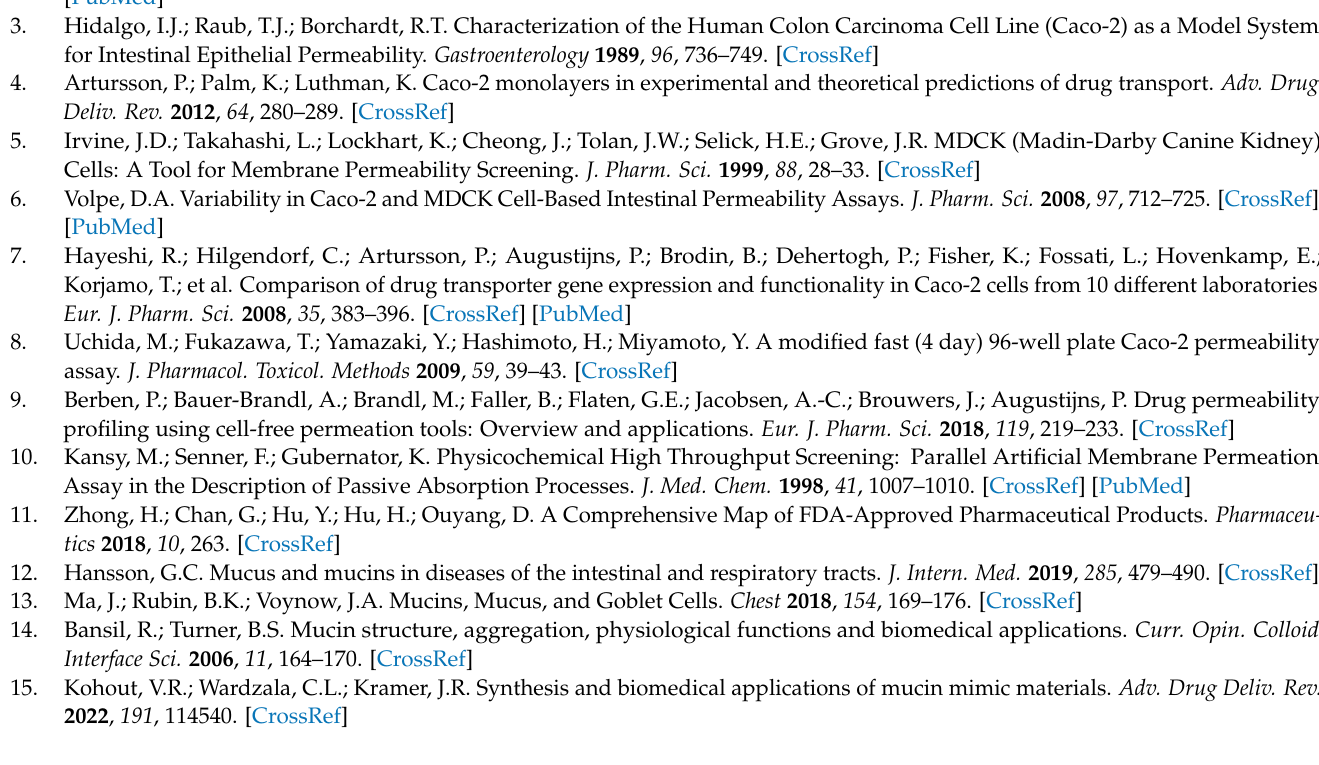
classification system. Figure S5: comparison of the apparent permeability measured without and with mucus. Table S1: molecular descriptors dataset. Table S2: HPLC-ESI-MS analytical conditions of the investigated drugs. Table S3: Compliance of the dataset to Lipinski’s rule of 5 (Ro5). The partition coefficient (cLogP) is the average of cLogP calculated with MarvinSketch, ADMETLab 2.0, and DataWarrior. Table S4: Compliance of the dataset to Veber’s rule. Table S5: Molecular descriptors that have the strongest correlation coefficient (Bravais-Pearson) with the apparent permeability (Papp). Table S6: Molecular descriptors that have the strongest correlation coefficient (Bravais-Pearson) with the apparent permeability (Papp) measured in the presence of